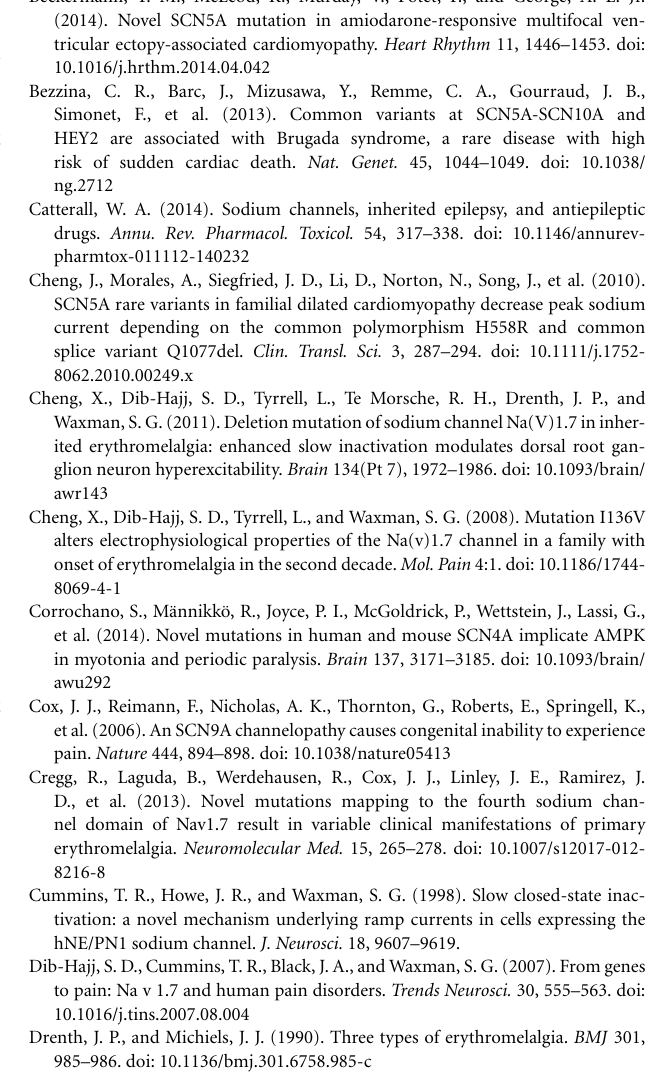
FIGURE 4 | The functional effect of the p.I141V mutation on the steady-state of activation and inactivation processes of Na v 1.5 channel (left panel). The presence of this mutation induces a negative shift of the